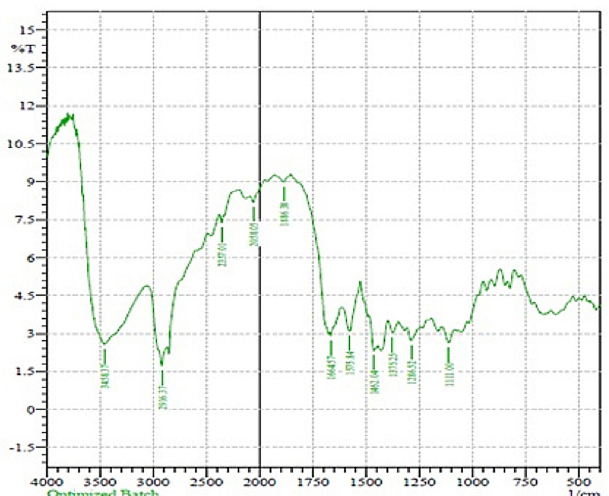
FIGURE 4 – FT-IR spectrum of metoprolol tartrate with sodium starch glycolate.